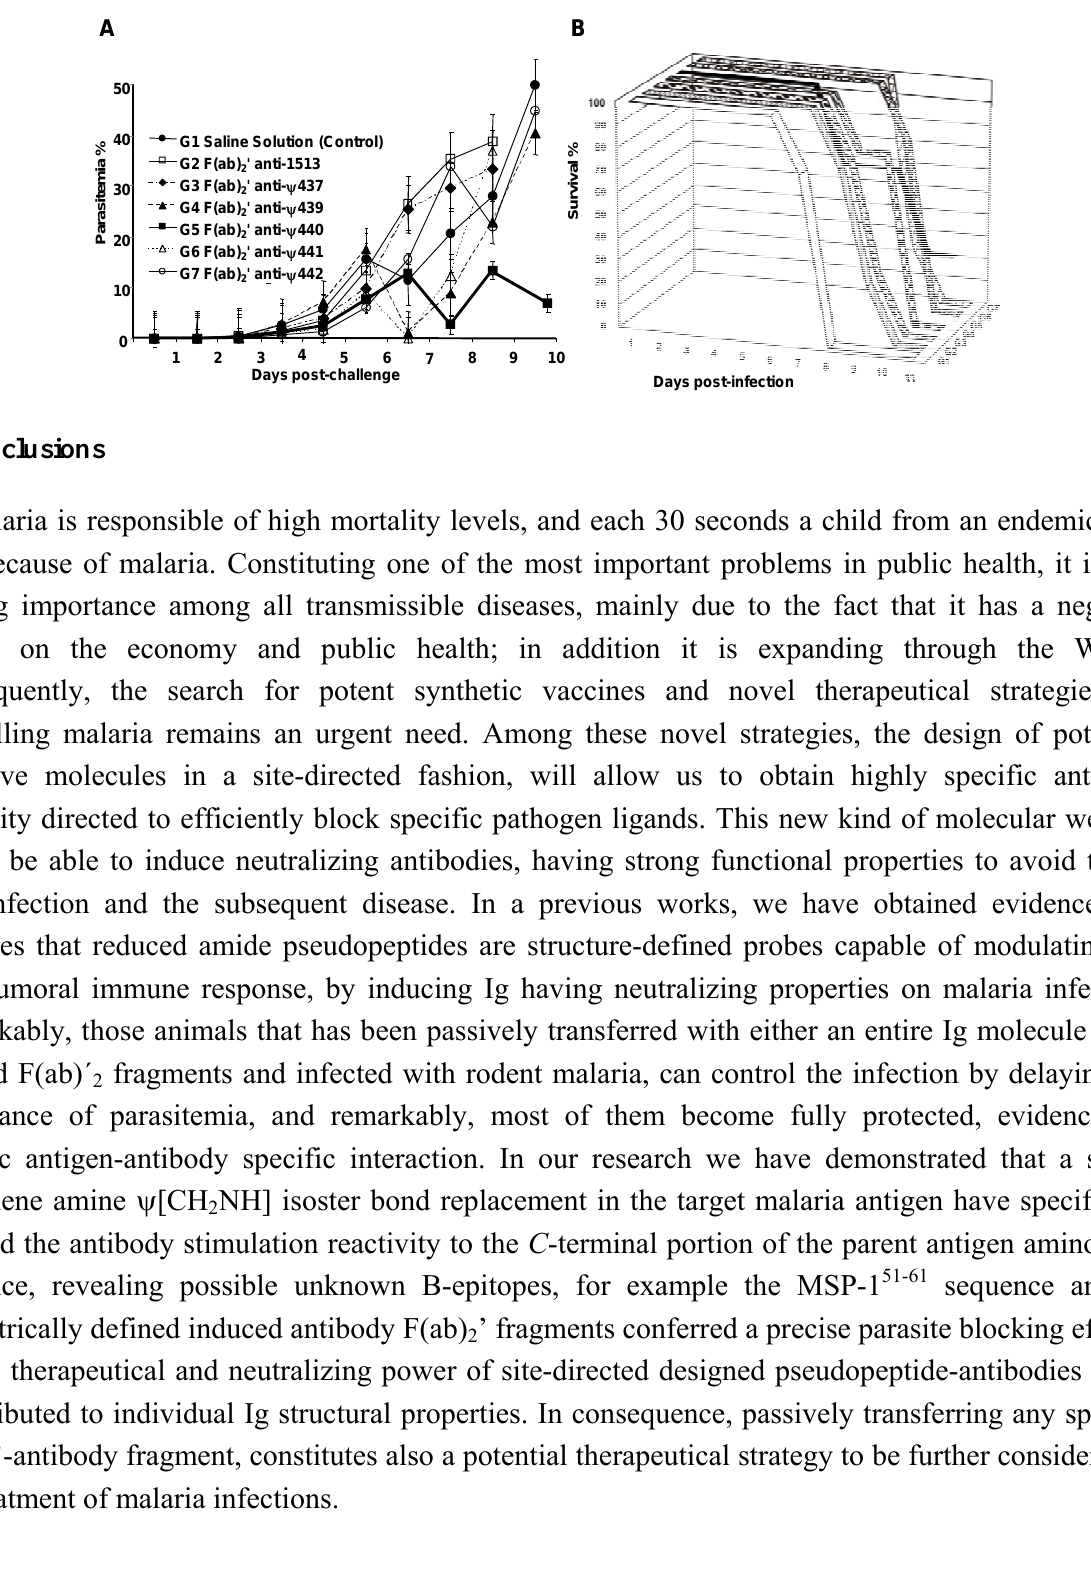
Figure 10. Course of parasitemia in BALB/c mice inoculated with different doses of P. yoelii- infected RBCs. A. Infection dose: 5 × 10 4 iRBCs. B. Infection dose: 25,000 iRBCs. Each line represents the mean parasitemia of each animal group with its corresponding